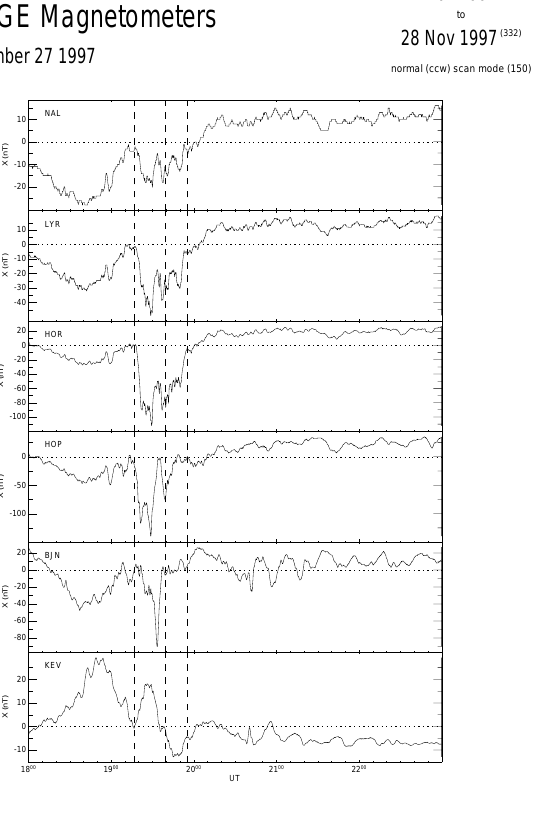
Fig. 3. (a) X (north-south) and (b) Z (vertical) magnetograms from the 5 IMAGE stations shown in Fig. 1 for the interval 18–23 UT on 27 November 1997. The dashed vertical lines identify times of